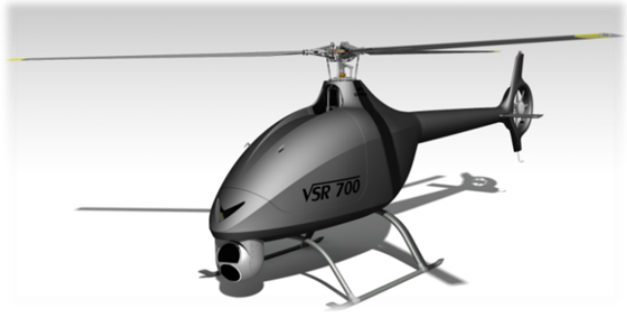
Figure 1. VSR700, the multi-mission naval UAS ( c (cid:13) Airbus).